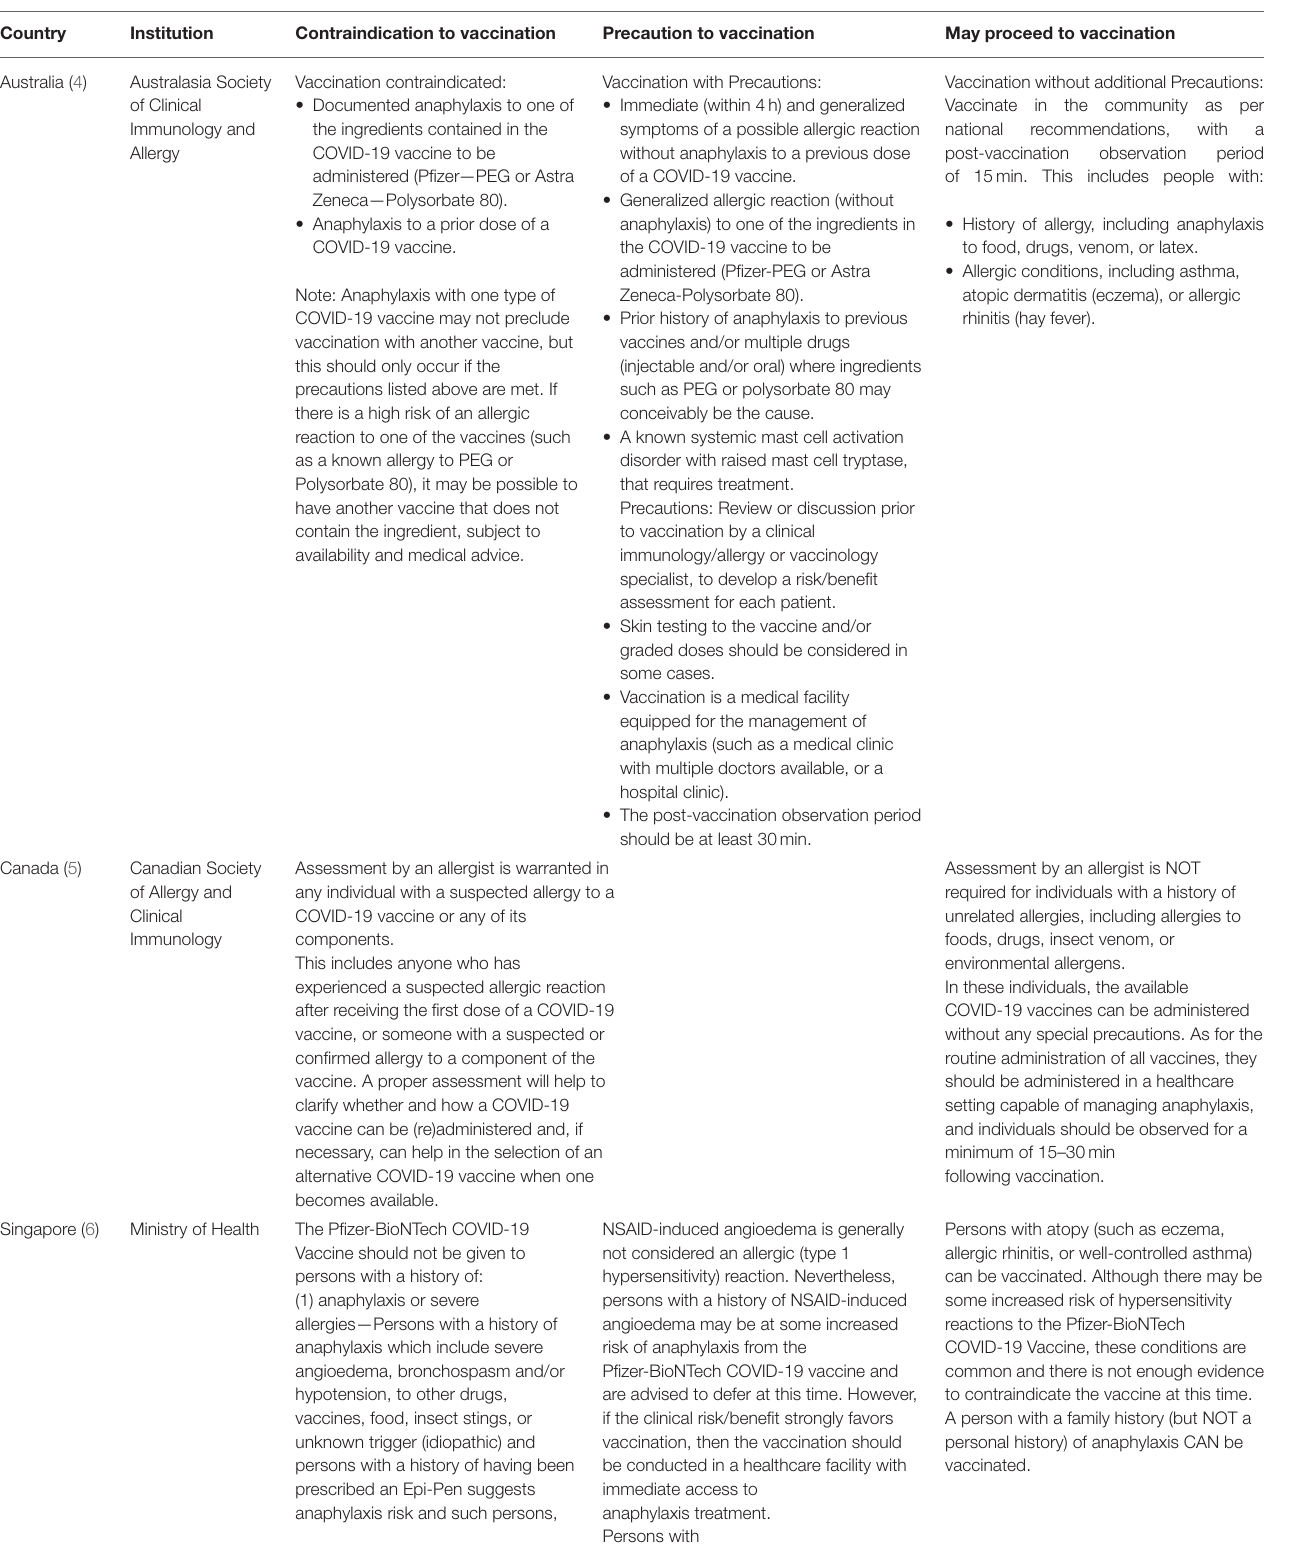
TABLE 4 | Summary of recommendations regarding COVID-19 vaccine allergy safety (VAS) in other countries.